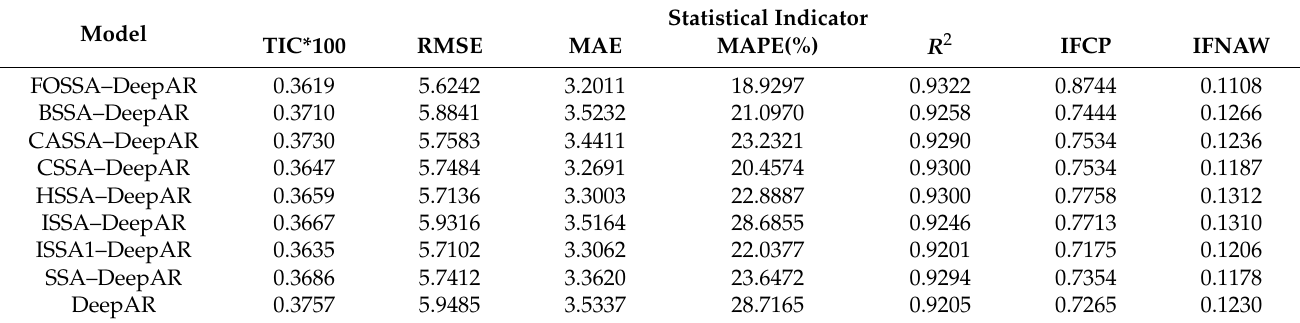
Table 4. Statistical indices of PM2.5 concentration prediction in